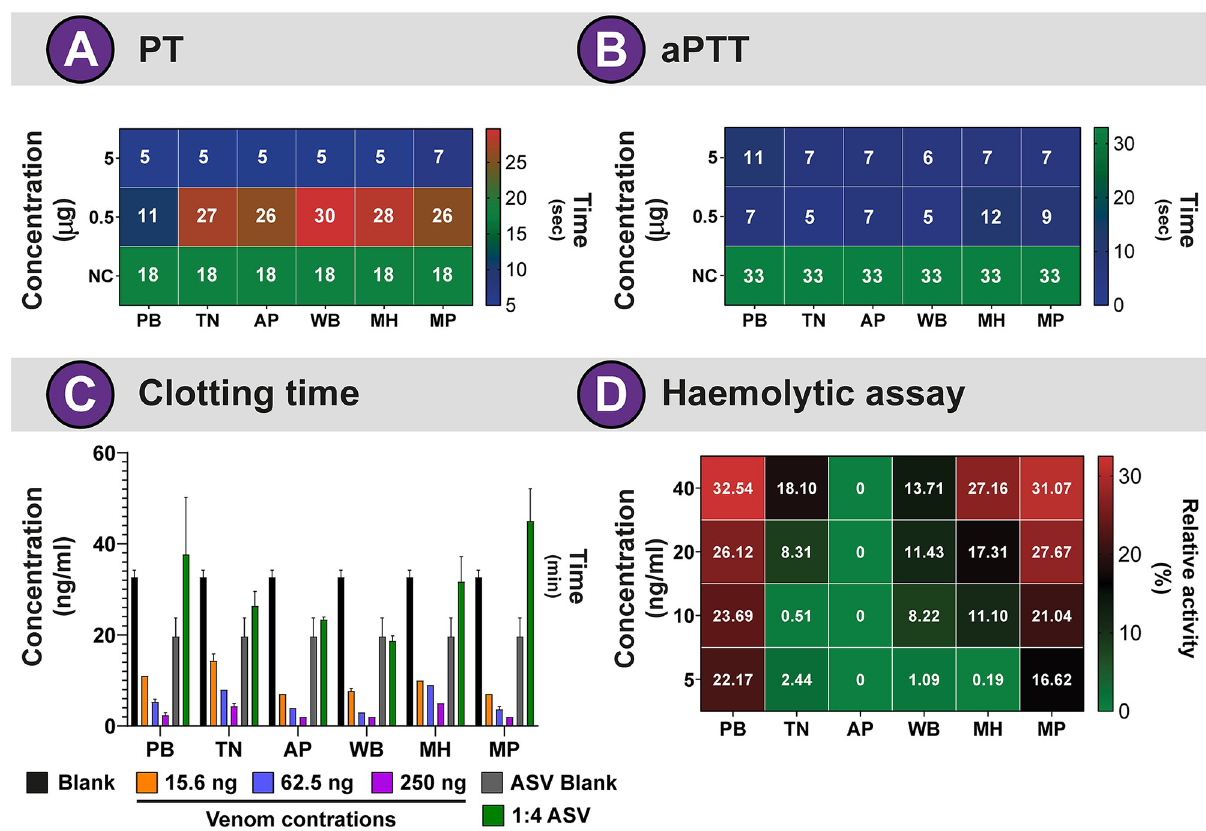
Fig 4. Coagulopathies induced by the biogeographically distinct populations of D . russelii . Heatmaps depict the influence of D . russelii venoms in impeding the (A) extrinsic and (B) intrinsic blood coagulation pathways, respectively. (C) The impact of varying concentrations of venoms (15.6 to 250 ng) on plasma clotting time (mins), and the ability of Premium Serums antivenom (1:4 dilution of 1 mg/ml or 0.25 μ g/ μ l antivenom) in neutralising these effects are shown as bar graphs. The error bars represent the standard deviation among the replicates. (D) Haemolytic activities of D . russelii venoms have also been shown. Numbers inside each tile in A and B denote the plasma clotting time in seconds, and the numbers in D indicate the percentage of relative activity with respect to the positive control (0.5% Triton X). Blank: plasma control; ASV Blank: plasma + antivenom (1:4); NC: negative control; PB: Punjab; TN: Tamil Nadu; AP: Andhra Pradesh; WB: West Bengal; MH: Maharashtra; MP : Madhya Pradesh.